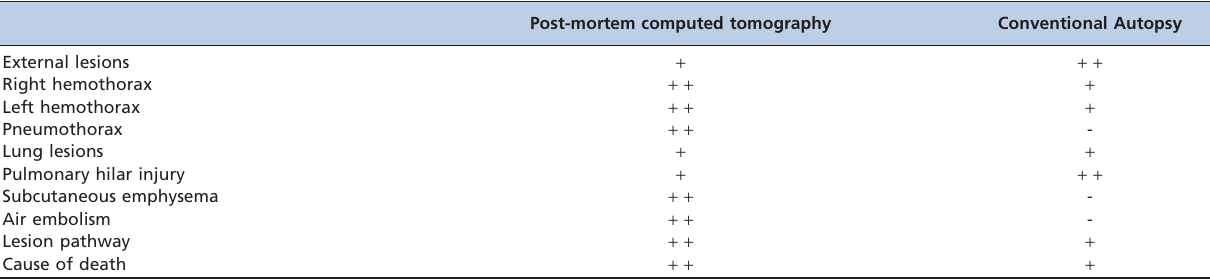
Table 1 - Comparison between the autopsy